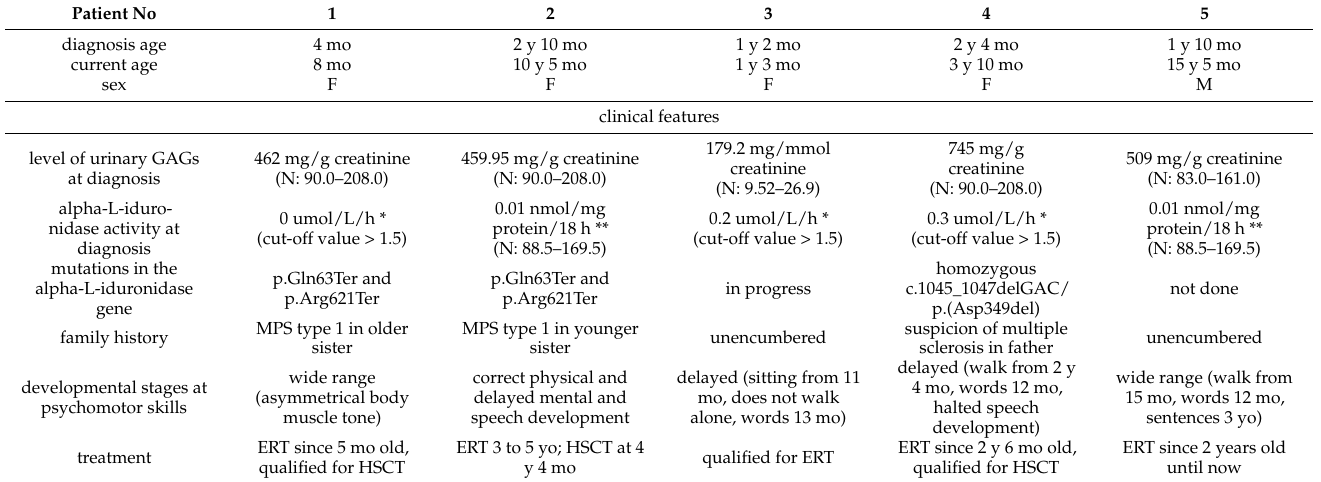
Table 4. Clinical analysis of children’s symptoms.